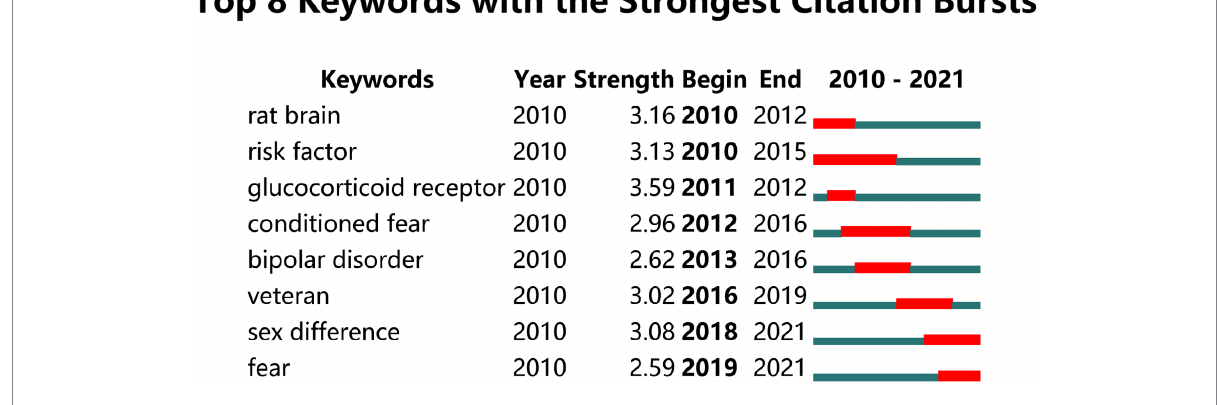
FIGURE 10 The 8 keywords with the strongest citation bursts in biomarker-related